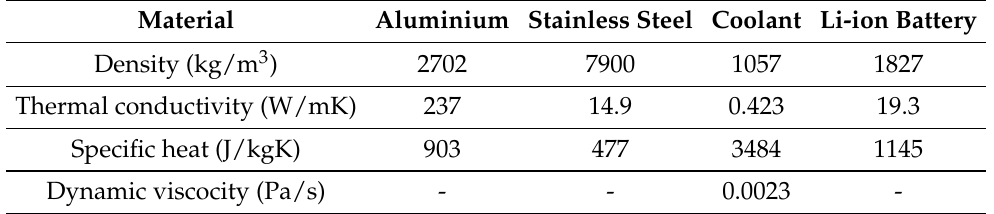
Table 1. Physical properties of the materials in the battery pack used in the